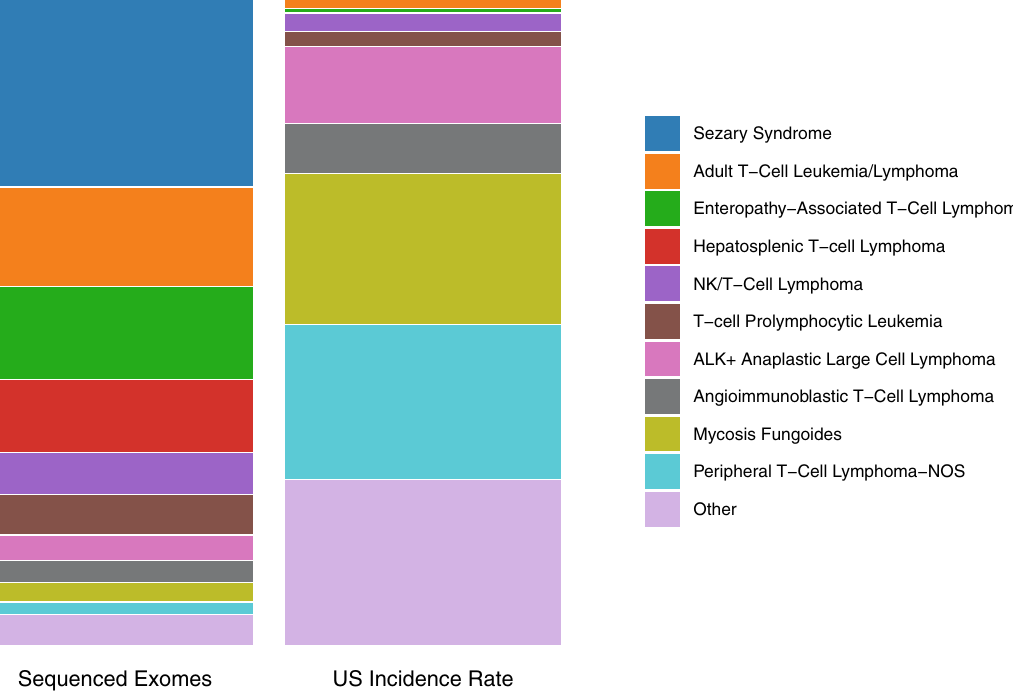
Figure 1. Comparison of the distribution of number of exomes sequenced with the US incidence rate of each subtype. Literature analysis identified 631 whole exome sequences performed on mature T-cell NHL samples. US Incidence rates are derived from the 2016 US lymphoid malignancy statistics 26 which estimated 8,380 new cases of mature T-cell NHL in 2016.